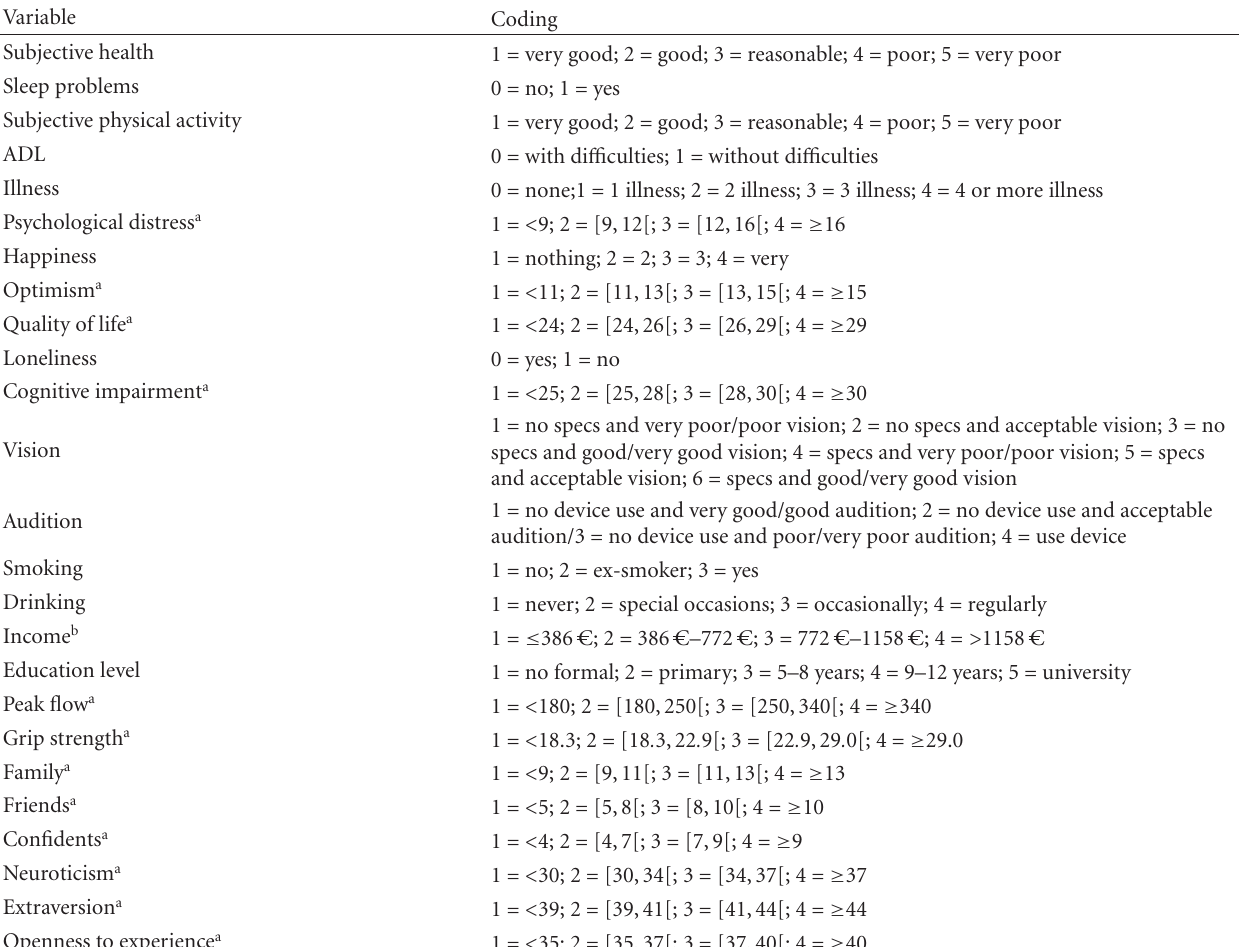
Table 2: Definition of